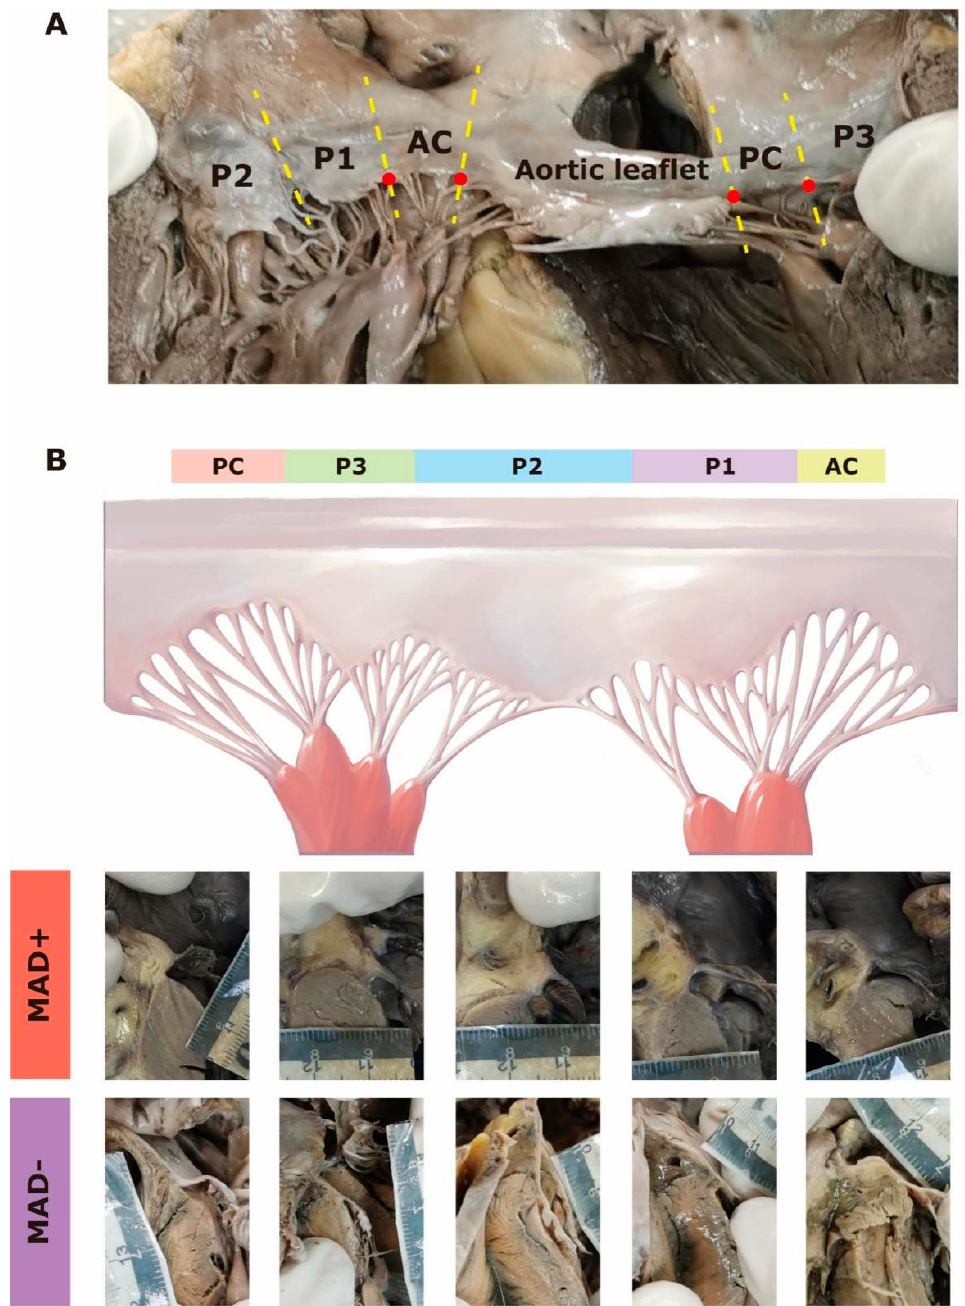
Figure 1. ( A ) Representative picture of the entire mitral annulus (atrial surface, dissecting from the cleft between P2 and P3 region). The mitral annulus was separated into six regions (by yellow dash lines): the anterior region (aortic leaflet), the posterior region (including P1, P2, and P3), and two commissural regions (i.e., AC and PC). Commissural regions were defined as between notches (red dots) of the anterior and the posterior leaflets. ( B ) Schematic diagram of the mitral annulus (upper; atrial surface, dissecting from the middle of the aortic leaflet). Mitral annular disjunction (MAD) could be observed in all regions. Representative pictures of MAD+ and MAD − of each region are shown (lower). AC = anterolateral commissure, PC = posteromedial commissure. The maximum disjunctional length of each region was recorded and standardized by the following method. The cut-off value (1.5 mm) was set as the baseline. Regions with a disjunctional length shorter than 1.5 mm, namely MAD − in this study, were adjusted to